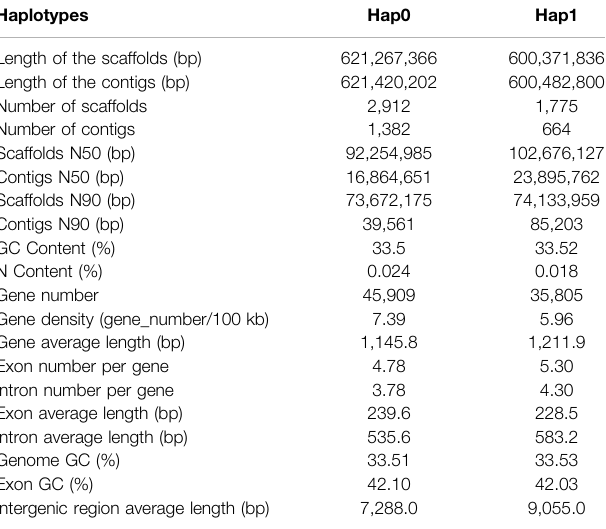
TABLE 1 | Genome assembly and annotation statistics for B. chinense DC. Haplotypes Hap0 Hap1 Length of the scaffolds